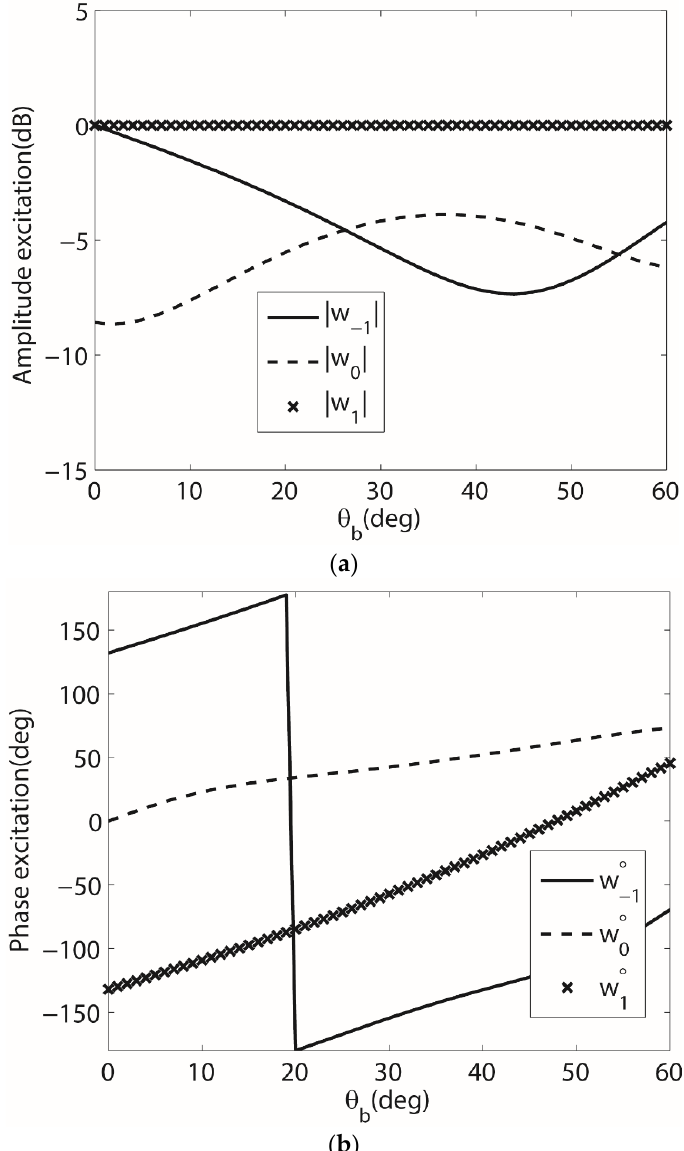
Figure 9. ( a ) Magnitude of the array weights for the 1 × 4 array on the singly curved (wedge) surface and ( b ) Phase of the array weights for the 1 × 4 array on the singly curved (wedge) surface.